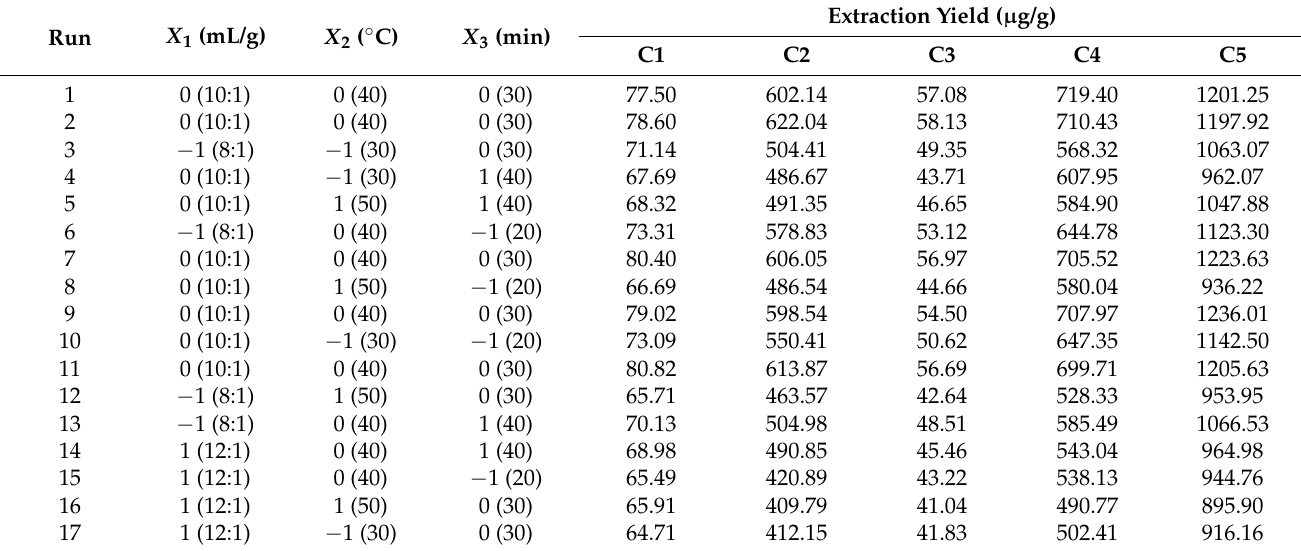
Table 2. Box-Behnken design for the independent variables and the observed